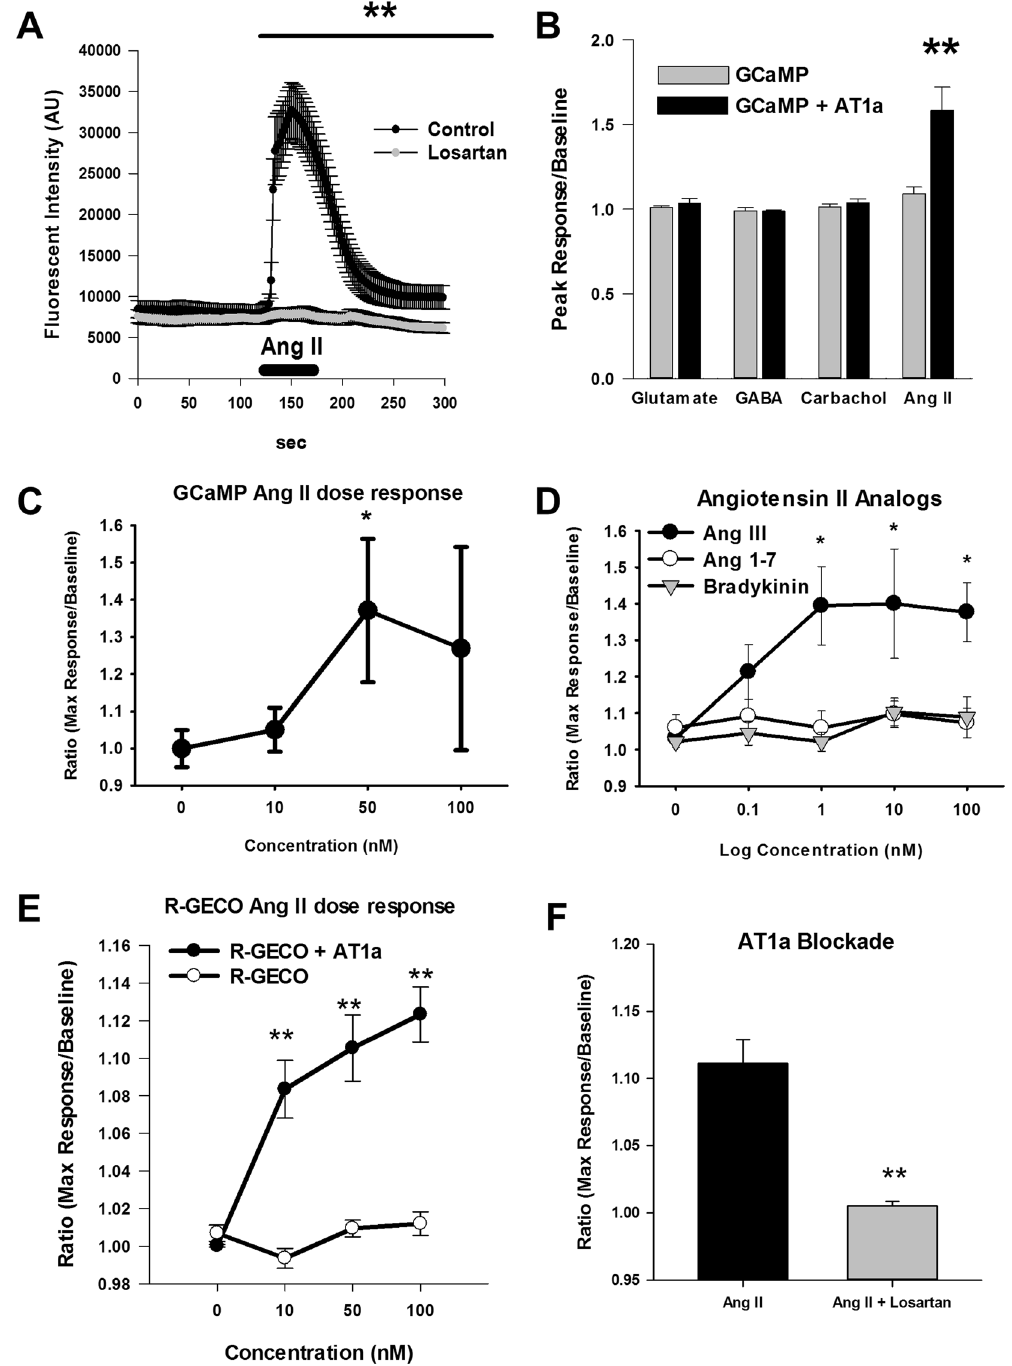
Figure 2. ANG II mediated increases in sniffer cell fluorescence. ( A ) ANG II (100 nM) induced a robust but transient increase in GCaMP fluorescence that was blocked by the AT1aR receptor antagonist Losartan (10 µ M). Control n = 39, Losartan n = 38. ( B ) Data shows that bath application of glutamate (50 µ M), GABA (50 µ M), and carbachol (50 µ M) failed to change fluorescent intensity of sniffer cells transfected with GCaMP (n = 29) or GCaMP + AT1aR (n = 38). ANG II (100 nM) did increase fluorescent intensity of sniffer cells, but only in sniffer cells transfected with GCaMP + AT1aR. Dose-dependent effects of ANG II and related compounds were also measured. ( C ) GCaMP + AT1aR sniffer cells exhibit dose-dependent increases in fluorescence in response to bath application of ANG II (100 nM, n = 10). ( D ) Bath application of ANG III induced a dose-dependent increase in GCaMP + AT1aR sniffer cell fluorescence. Bath application of ANG (1–7) or bradykinin did not induce a change in GCaMP + AT1aR sniffer cell fluorescence at any of the doses tested (0.1–100 nM, n = 17–41). ( E ) R-GECO + AT1aR sniffer cells exhibit dose-dependent increases in fluorescence in response to bath application of ANG II (n = 17). R-GECO only cells did not respond to ANG II (n = 27). ( F ) ANG II-mediated increases in R-GECO + AT1aR are blocked by bath application of Losartan (10 µ M, n = 17). * p < 0.05, ** p <